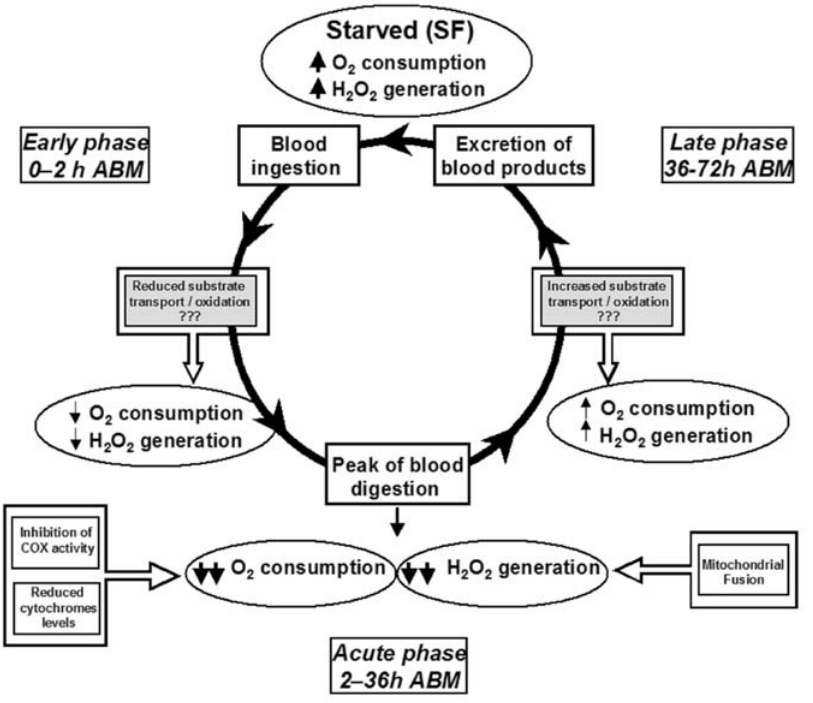
Figure 4. Schematic representation of the effects promoted by blood feeding on A.aegypti FM mitochondria. In starved insects (sugar- fed, SF) the oxygen consumption and H 2 O 2 generation rates the levels of cytochromes c and a + a 3 , as well as the activity of COX, are high. Also, in SF mosquitoes mitochondria are less fused. Ingestion of vertebrate blood triggers a cascade of events that change over time after blood meal (ABM), which takes around 72 h (inner bold black circle). Our results indicate three distinct phases in which changes in mitochondrial structure and function occurs over time in A. aegypti FM. These events paralleled blood intake and digestion. First is the ‘‘early’’ phase, which occurs in the first two hours ABM and is characterized by a mild reduction in both oxygen consumption and H 2 O 2 generation rates. We speculated that midgut distention induced the release of factors that would reduce substrate transport/oxidation, which mechanistically could explain these events [58]. In the ‘‘acute’’ phase, between 2 h and 36 h ABM, the effects of BF on mitochondrial structure and function are further potentiated being oxygen consumption and H 2 O 2 generation drastically reduced. At this phase, COX activity and cytochrome levels were significantly reduced and mitochondria are more fused. Finally, at the ‘‘ late ’’ phase, between 36 h and 72 h ABM, most of the mitochondrial changes observed here are restored to levels similar to